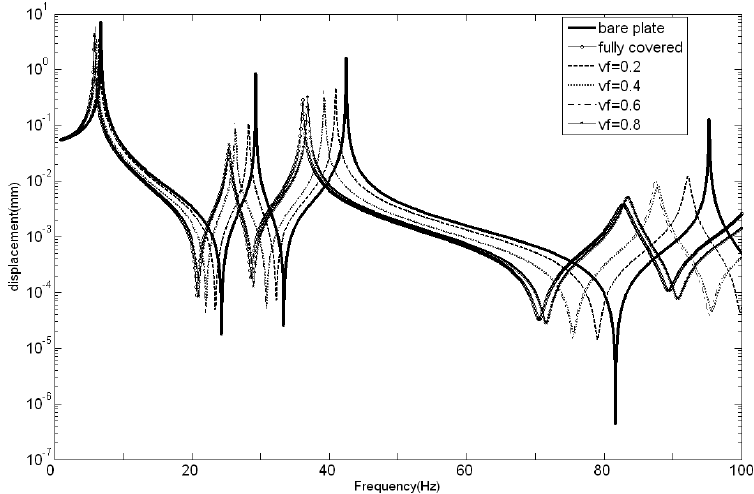
Fig. 13. Frequency response at the mid-point of free short edge excited by unit harmonic force at the same point.